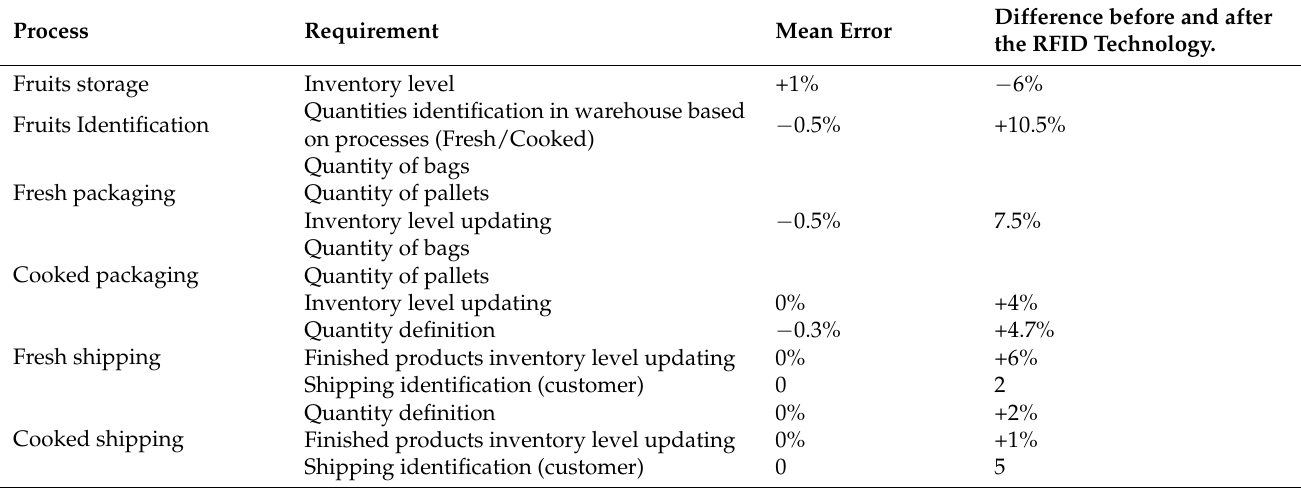
Table 9. Improvements evaluations for warehouse